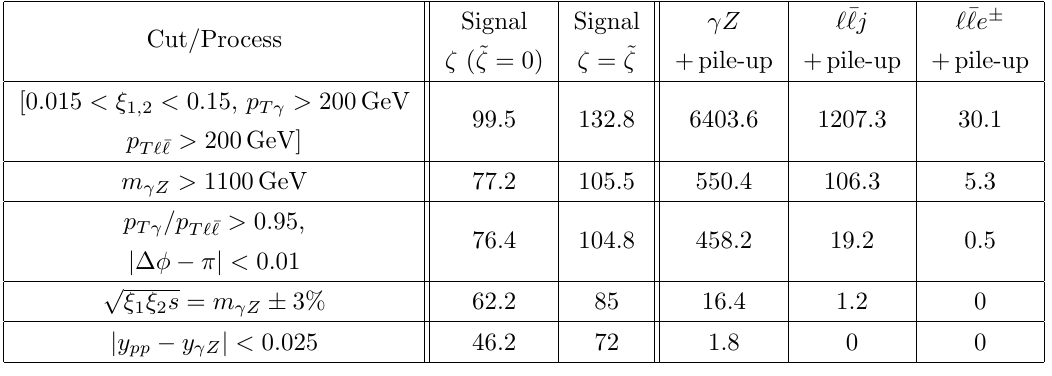
Table 3 . Same as table 2, but with an integrated luminosity of 3000 fb (cid:0) 1 . We are left with (cid:25) 2 background events after all the selection cuts with a signal e(cid:14)ciency of 50%.